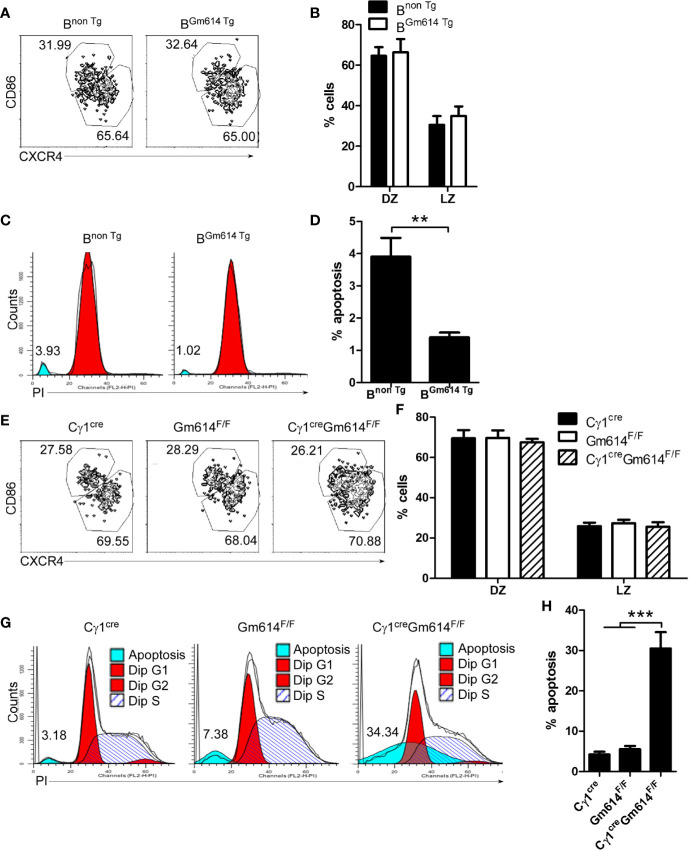
Gm614 suppressed GC B cell death. Nine-week-old Bnon Tg and BGm614 Tg
(A–D), or Cγ1cre, Gm614F/F, and Cγ1creGm614F/F
(E–H) mice were i.p. injected with 0.5 ml pristane and analyzed 6 months after injection. (A, B) Gm614 Tg did not affect the percentages of B cells in dark zone (DZ) and light zone (LZ). On gated CD19+B220+CD38loGL7hi GC B cells, CD86loCXCR4hi DZ and CD86hiCXCR4lo LZ B cells were analyzed by FACS. The percentages of splenic DZ and LZ B cells (A) and their statistical analysis (B) are shown. (C, D) Gm614 Tg suppressed GC B cell death. Splenic CD19+B220+CD38loGL7hi GC B cells were sorted by FACS and stained with PI (Propidium). The percentages of dead cells (C) and their statistical analysis (D) are shown. (E, F) Gm614 cKO did not affect the percentages of B cells in DZ and LZ. On gated CD19+B220+CD38loGL7hi GC B cells, CD86loCXCR4hi DZ and CD86hiCXCR4lo LZ B cells were analyzed by FACS. The percentages of splenic DZ and LZ B cells (E) and their statistical analysis (F) are shown. (G, H) Gm614 cKO promoted GC B cell death. Splenic CD19+B220+CD38loGL7hi GC B cells were sorted by FACS and stained with PI. The percentages of dead cells (G) and their statistical analysis (H) are shown. (A–H) Data represent three independent experiments, with six samples per group per experiment. Two-Way (B, F) and One-Way (H) ANOVA was followed by Bonferroni post-tests and two tailed Student’s t-test (D), Error bars, s.e.m., **p < 0.01, ***p < 0.001.